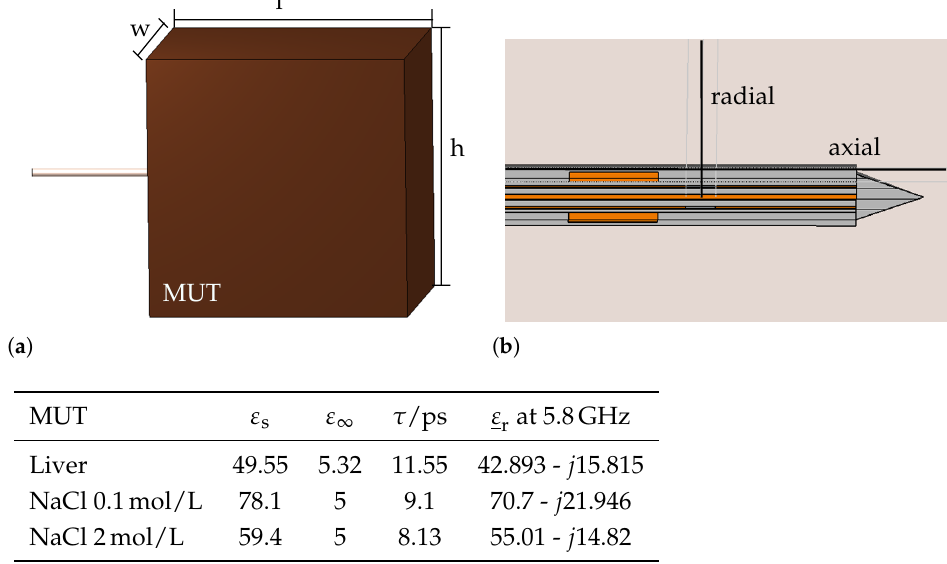
Figure 2. Simulation model of the dual-mode applicator. ( a ) Overview of the three-dimensional simulations model, when the applicator is inserted into MUT; ( b ) applicator geometry with evaluation curves along the axial and radial direction; ( c ) Debye model parameters of MUTs and complex relative dielectric constant at 5.8GHz. The dielectric propertiey data of liver tissue and NaCl solutions were taken from [24] and [25], respectively.